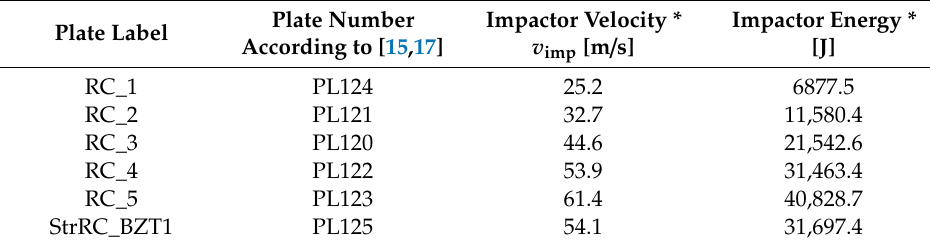
Table 1. Specimen identification, impact velocities and energies.